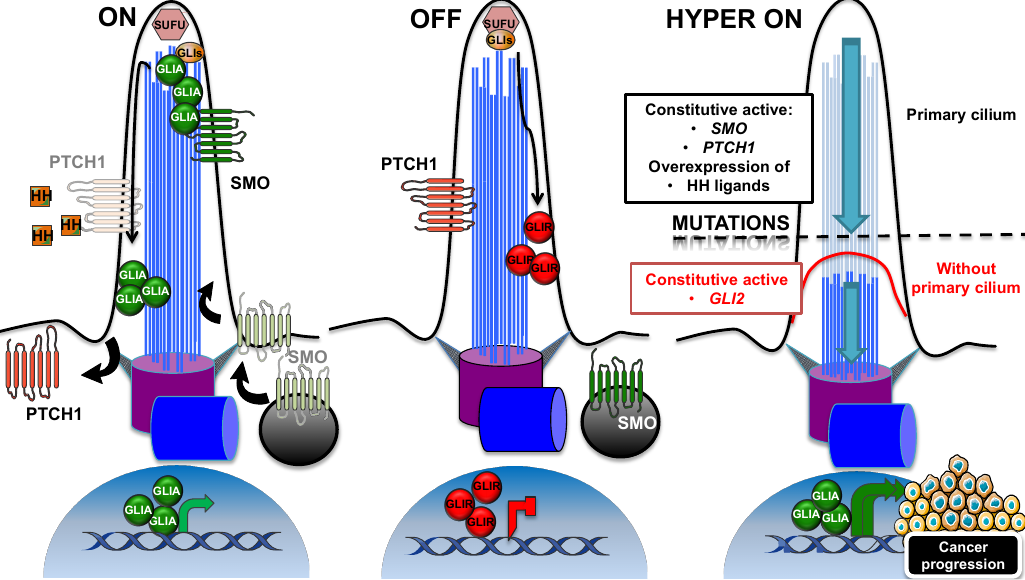
Figure 2. Cilia-dependent regulation of the Hedgehog signaling pathway. Schematic representation of the Hedgehog pathway repression and activation, in the presence or absence of a ligand. In Panel “ON”, in the presence of ligand binding to PTCH1 receptor, SMO moves into the cilium, and PTCH1 is displaced outside. In the cilium, SMO inhibits SUFU, and it activates GLI transcription factors (GLIA), which, in turn, activate the expression of target genes. In contrast, in Panel “OFF”, in the absence of a ligand, PTCH1 receptor localizes at the primary cilium, and the 7-transmembrane domain protein SMO is in vesicles outside the cilium. GLI transcription factors are sequestered and suppressed by SUFU, and processed into their repressive forms (GLIR), thus repressing the expression of target genes. If the pathway is misregulated, “HYPER ON” (i.e., SMO , PTCH1 mutations, in medulloblastoma and basal cell carcinoma), the activation of the pathway throughout the cilium can induce tumorigenesis, and targeting of the cilium can turn off the pathway and reduce cell proliferation. On the other hand, if the misregulation of the pathway arises downstream (i.e., GLI2 mutations), the loss of the cilium can also boost medulloblastoma or basal cell carcinoma development, suggesting that the role of primary cilia in Hedgehog misregulation-driven cancers depends on the oncogenic alteration. GLI: GLI family zinc fingers; PTCH1: Patched-1; SMO: Smoothened; SUFU: Suppressor of Fused.